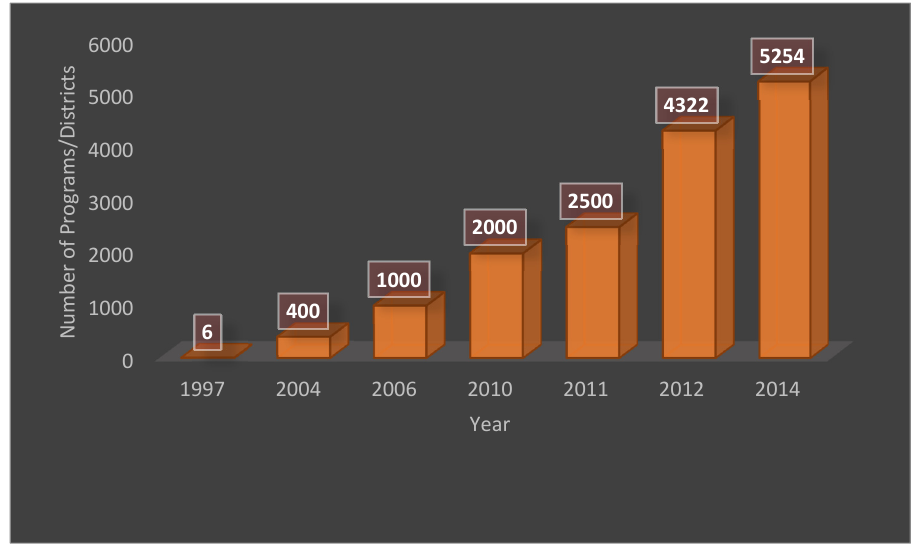
Figure 1. Growth in farm to school programs.